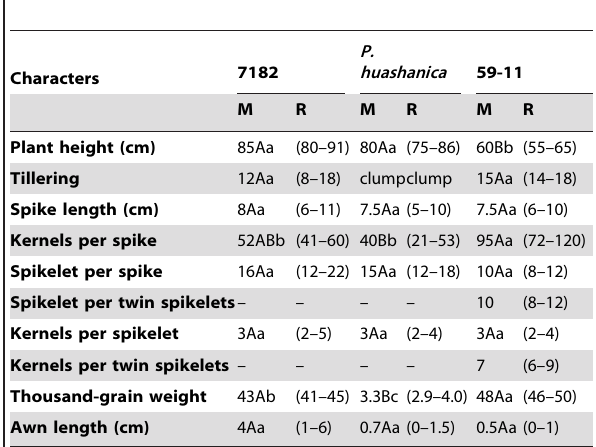
Table 1. Morphological characteristics of 7182, Psathyrostachys huashanica, and the 6Ns addition line.